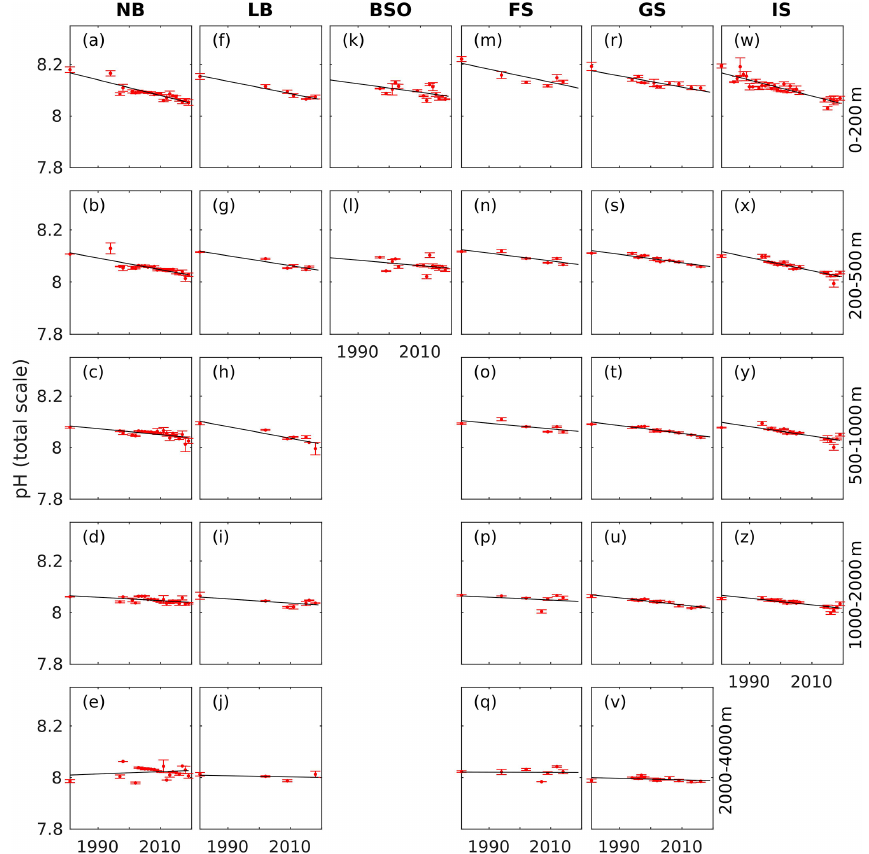
Figure 7. Annual mean pH (red dots) with standard deviation (error bars) at five different depth intervals in the Norwegian Basin (NB), Lofoten Basin (LB), Barents Sea Opening (BSO), Fram Strait (FS), Greenland Sea (GS), and Iceland Sea (IS; Fig. 1), which is calculated as described in Sect. 4.2. The solid black line show the trend estimate from the linear